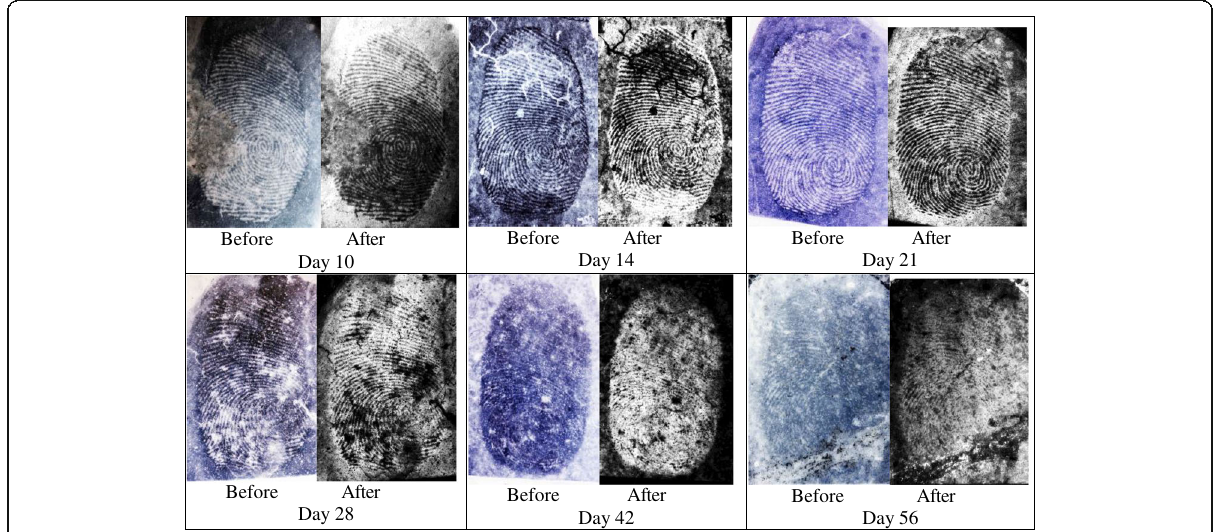
Fig. 18 Pre- and post-digital enhancement of “ second lift ” fingermarks on the “ face up ” surface of the metal plates